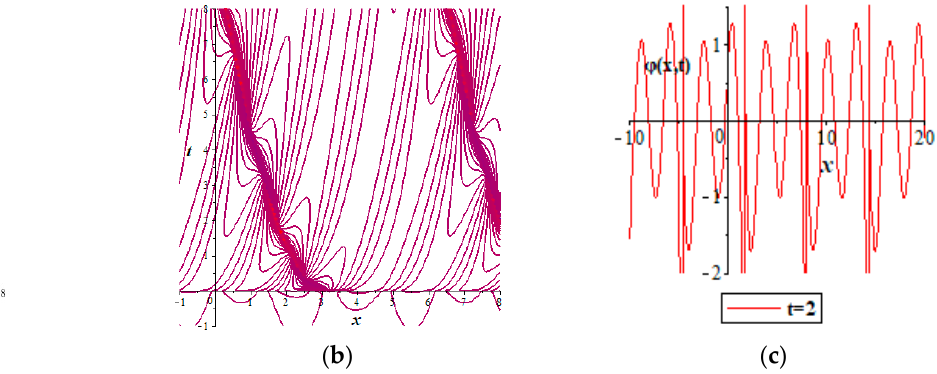
ϕ Figure 2. ( a – c ) Present imaginary part of solitonic wave ),( tx of Equation (23) for the paramet- Figure 2. ( a – c ) Present imaginary part of solitonic wave φ ( x , t ) of Equation (23) for the parametric =−==== tghk γ ric situations .2,2,1,5.0,5.0 ( a ) Complex surface in 3D; ( b ) Complex situations k = 0.5, γ = 0.5, h = 1, g = − 2, t = 2. ( a ) Complex surface in 3D; ( b ) Complex shape in contour; ( c ) Complex shape in 2D. shape in contour; ( c ) Complex shape in 2D.